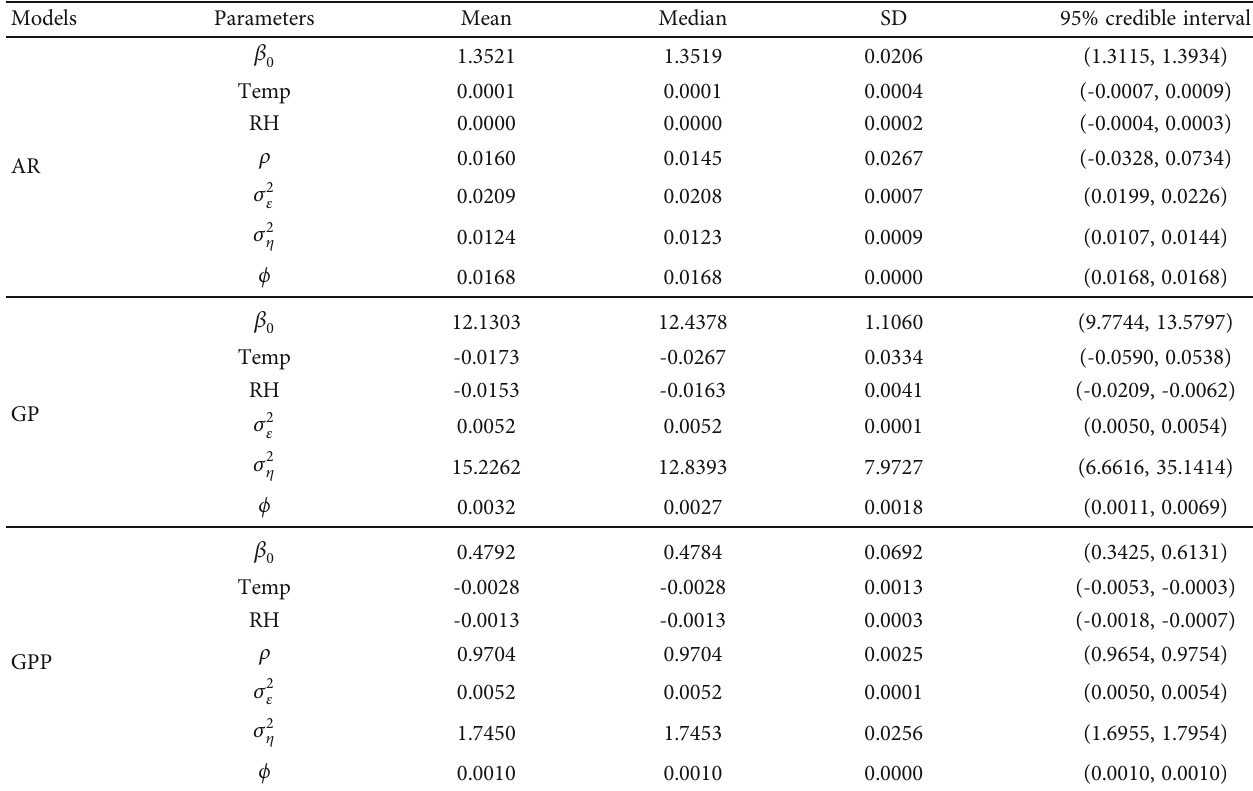
Table 3: Posterior estimates and 95% credible interval for the parameters of the AR, GP, and GPP models fi tted for PM levels. SD stands for standard deviation.